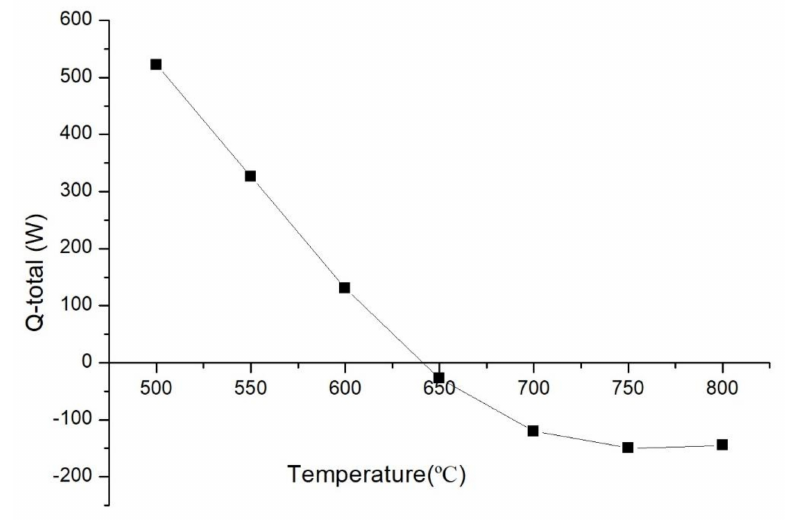
Figure 14. The e ff ect of temperature on the simulation system heat output.